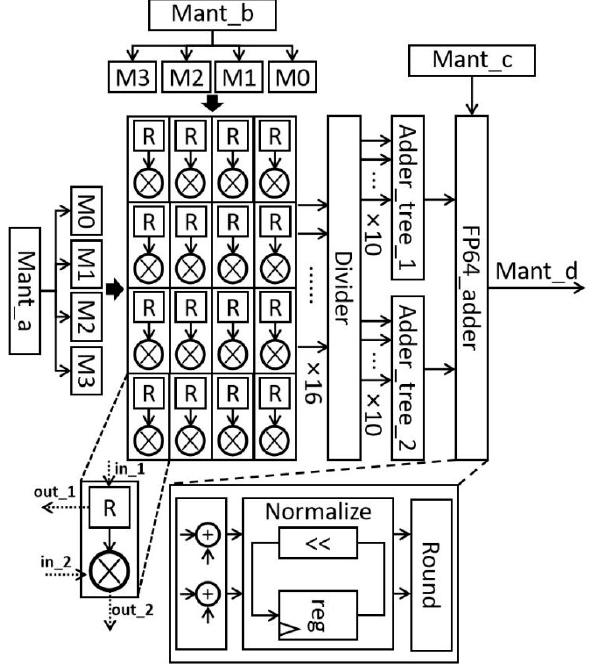
Figure 4. Illustration of the DCIM-FF macro.